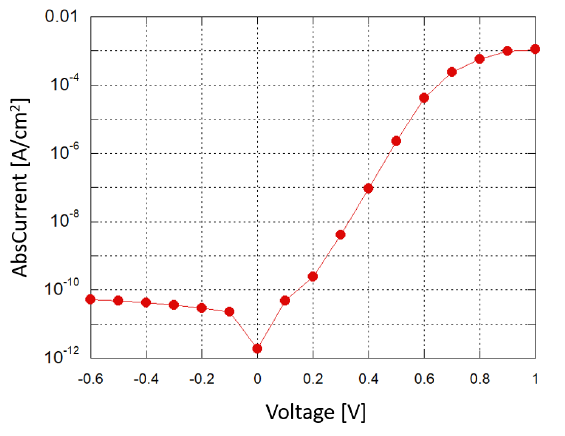
Figure 6. Photodiode: current density vs. applied voltage in a semi-logarithmic